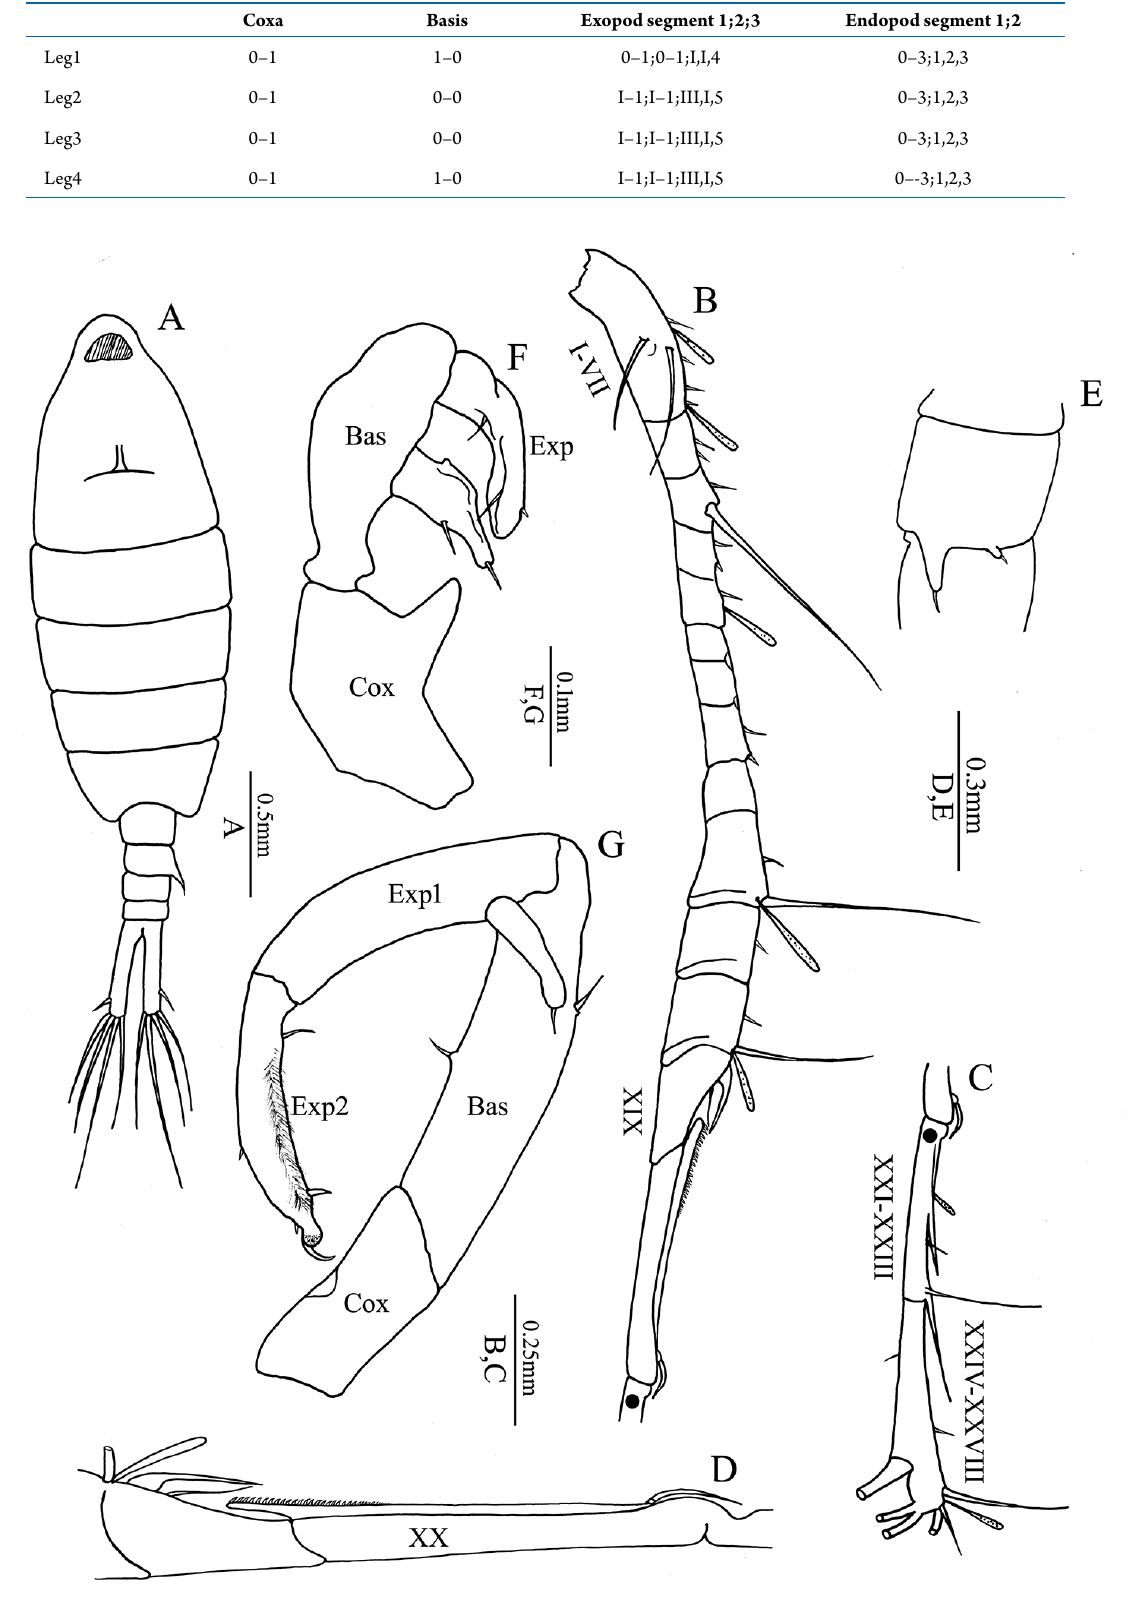
Figure 4. Tortanus ( Atortus ) dhritiae sp. nov. male (allotype): A ) habitus dorsal view; B , C , D ) antennule; E ) urosome second segment right lateral view; F ) right leg 5 posterior view; G ) left leg posterior